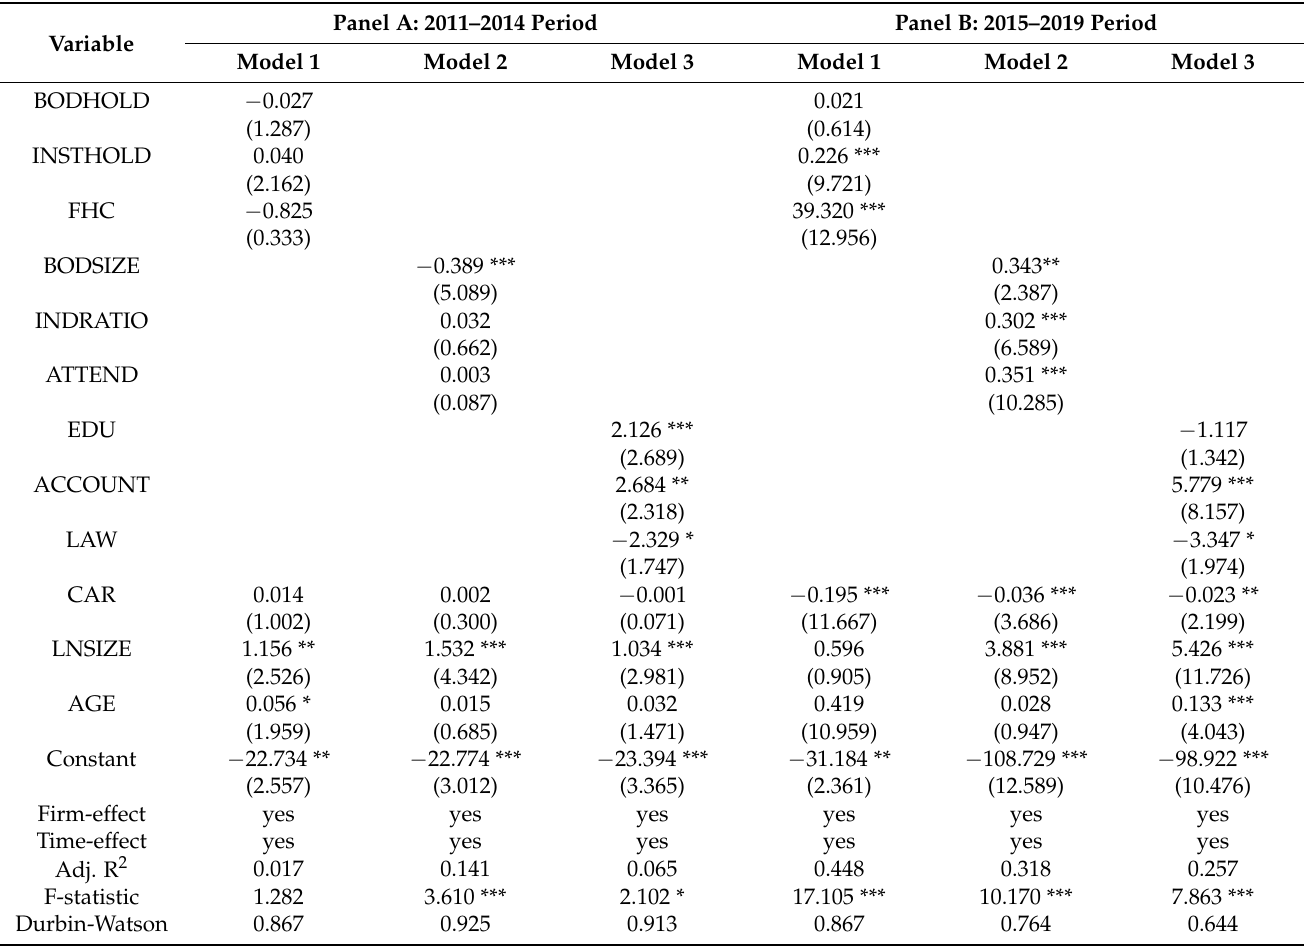
Table 4. The correlation between corporate governance and financial